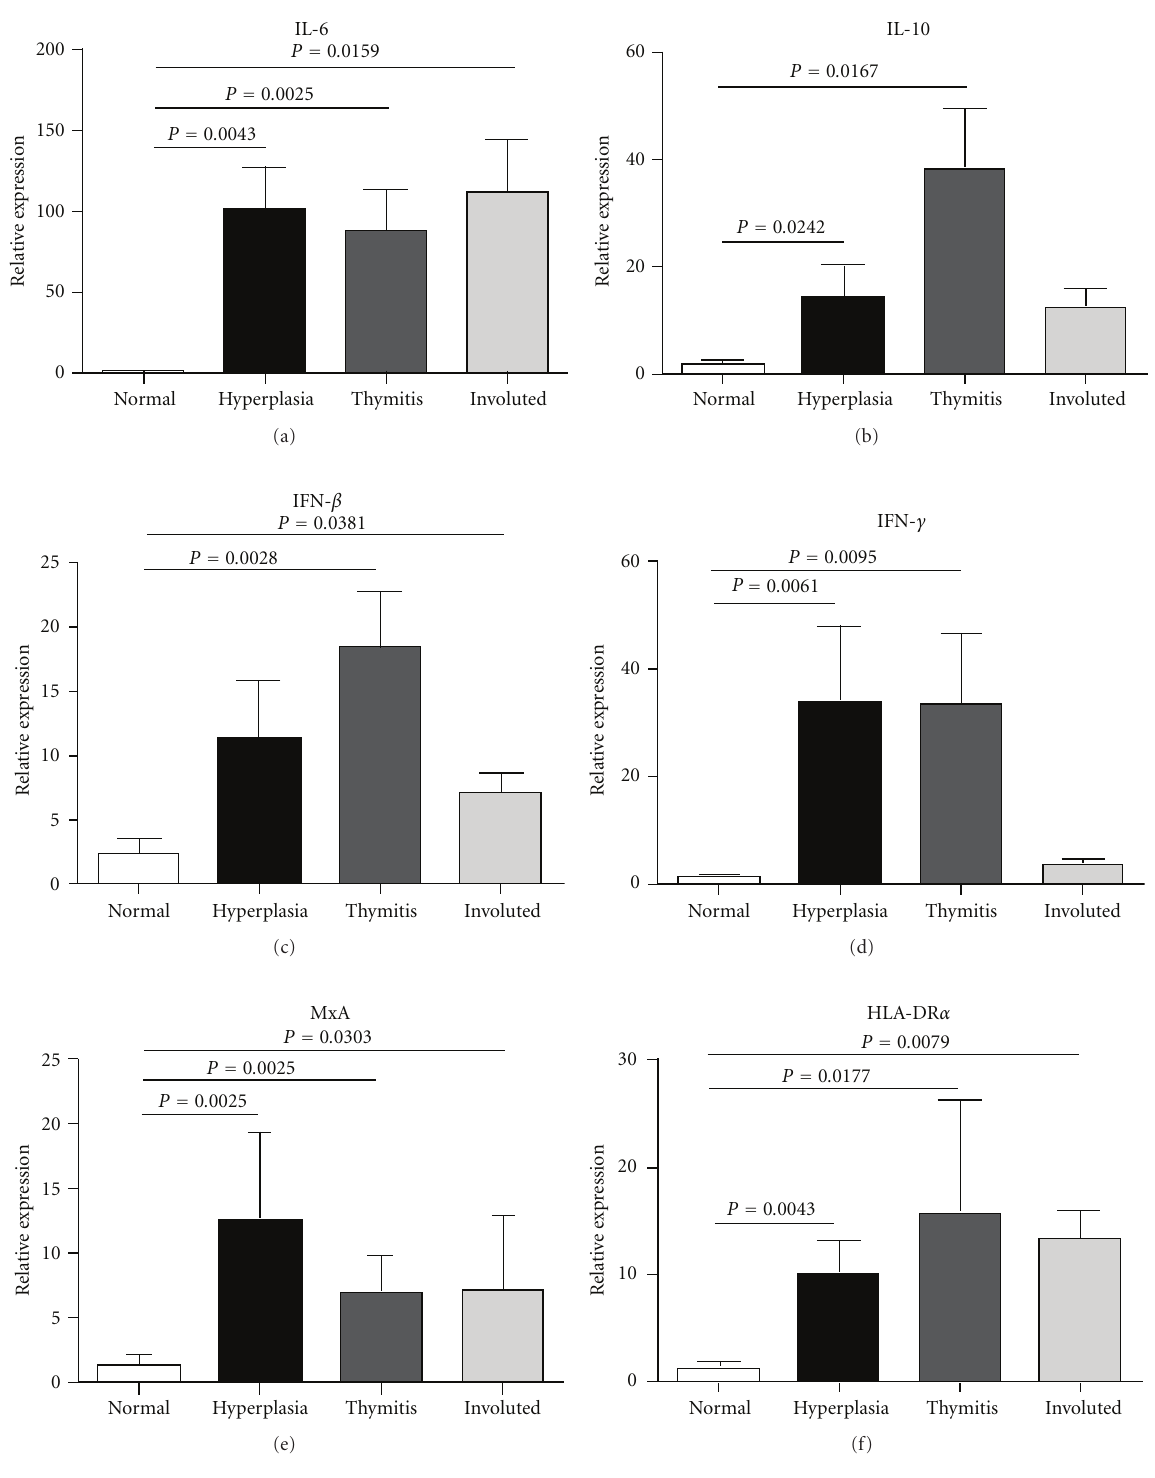
Figure 1: Relative expression of IL-6 (a), IL-10 (b), IFN- β (c), IFN- γ (d), MxA (e), and HLA-DR α (f) in the thymus of MG patients. The transcripts were analysed by real-time PCR analysis starting from total RNA extracted from the thymus of MG patients with hyperplasia ( n = 9), thymitis ( n = 9), and thymic involution ( n = 9), and 7 healthy subjects. Relative expression of the 6 genes was normalized to GAPDH and calculated as 2 − ΔΔ Ct ; normalized values for nonpathological thymuses were used as calibrator. Values shown are means ± SEM of duplicate determinations. P values were obtained by the Mann-Whitney U